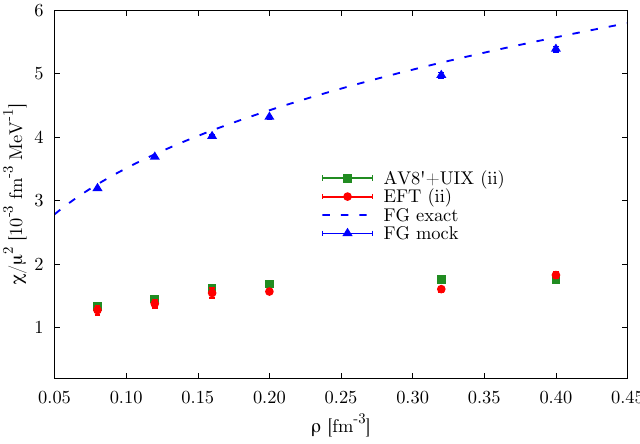
Figure 6. Spin susceptibility χ in PNM for the AV8 (cid:48) + UIX (green squares) and the local chiral EFT (red circles) potentials as a function of the density from approach (ii). Results for AV8 (cid:48) + UIX from approach (i) are shown with blue triangles. Uncertainties on the fitting parameters have been propagated and they are shown by the error bars.